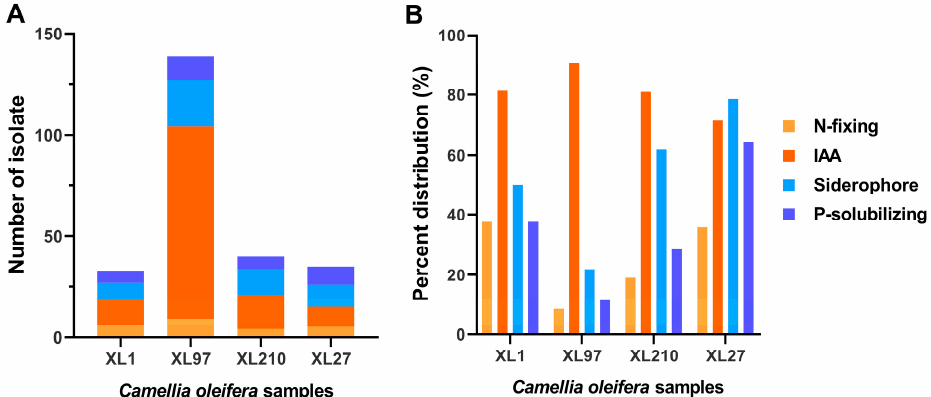
Figure 4. Numbers ( A ) and percent distribution ( B ) of culturable endophytic actinobacterial isolates purified from different C. oleifera samples with plant growth promotion traits.